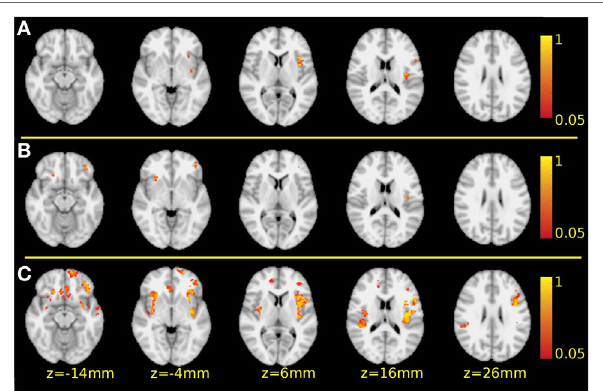
TaBle 2 | Significant volumetric clusters of gray matter volume deficits in the group of patients with schizophrenia compared to the healthy controls.